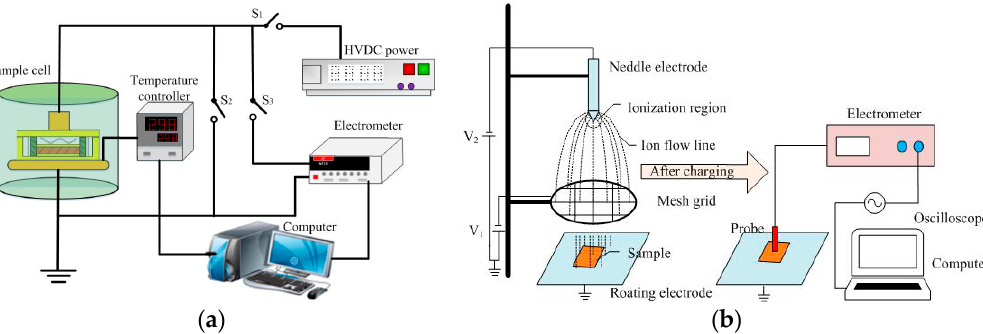
Figure 2. Schematic diagrams of: ( a ) The thermally stimulated depolarization current (TSDC) method and ( b ) the isothermal surface potential decay (ISPD) method.